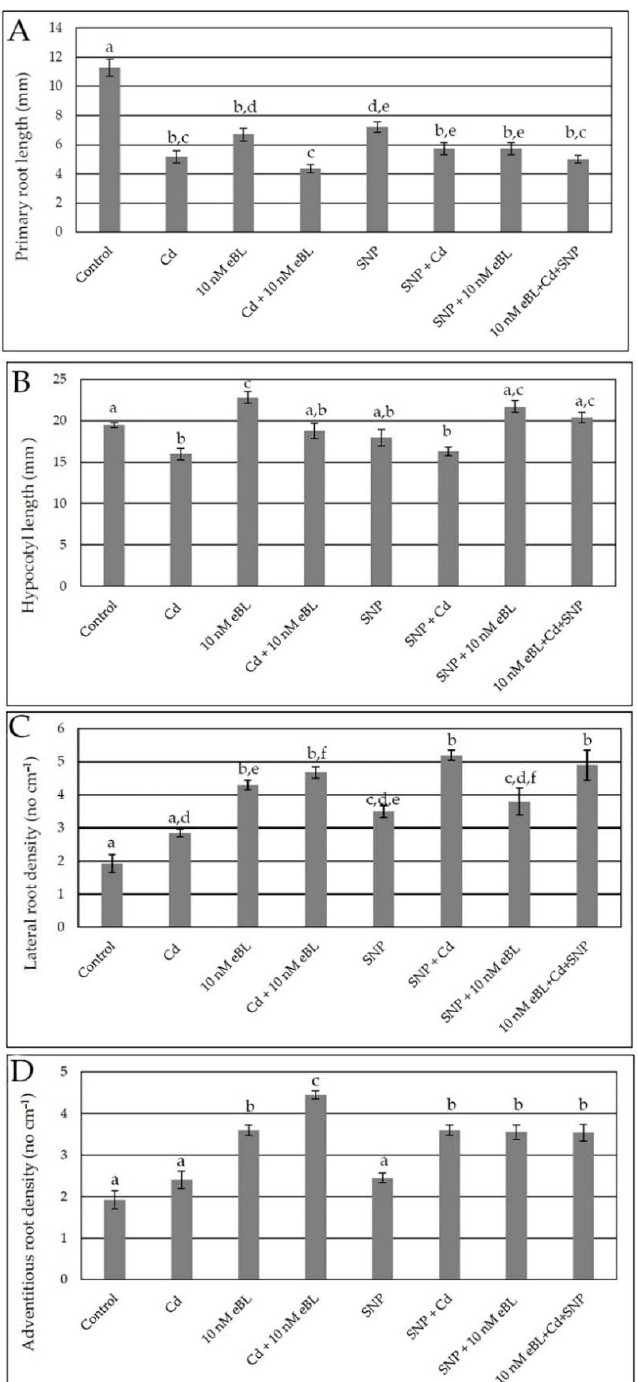
Figure 6. Primary root mean length (±SE) ( A ), hypocotyl mean length (±SE) ( B ), mean density of lateral roots (±SE) ( C ) and mean density of adventitious roots (±SE) ( D ) of Col seedlings cultured for 9 days under continuous darkness followed by 7 days under 16 h light/8 h darkness photoperiod on ½ MS medium (see Section 4) (Control treatment), or on the same medium plus either 60 μ M CdSO 4 (Cd) or 10 nM eBL, or Cd + 10 nM eBL, or 50 μ M SNP (SNP), or 50 μ M SNP + 60 μ M Cd (SNP + Cd), or 50 μ M SNP + 10 nM eBL (SNP + 10 nM eBL), or 10 nM eBL + 60 μ M CdSO 4 + 50 μ M SNP (10 nM eBL + Cd + SNP). Different letters show significant differences for at least p < 0.05. Columns followed by the same letters are not significantly different. n = 30. Data from the first replicate.